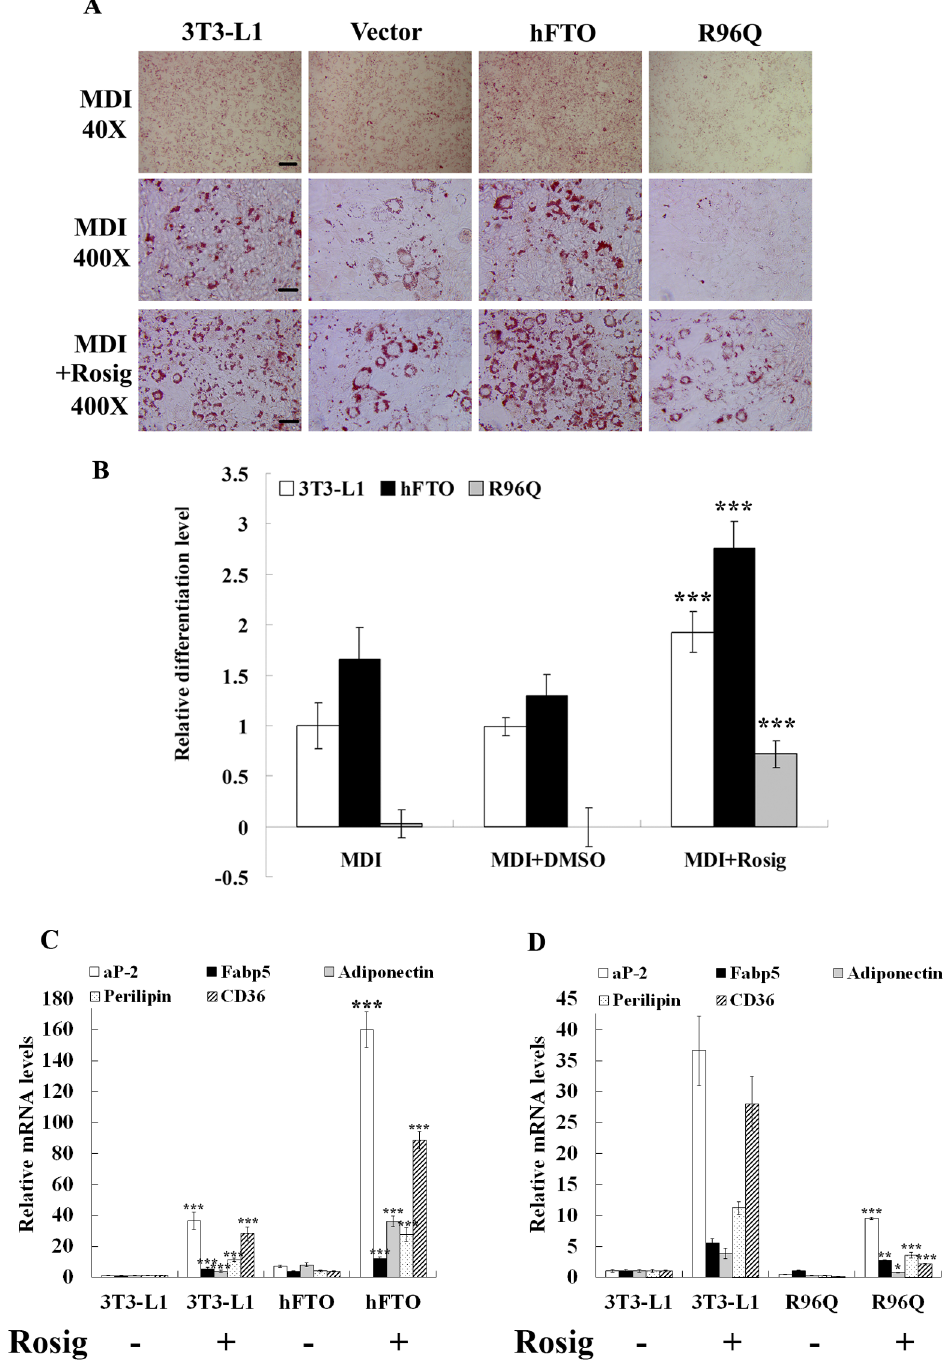
Fig 3. Rosiglitazone rescued adipogenesis inhibition in 3T3-L1 cells expressing R96Q. (A) Oil Red-O staining of 3T3-L1 cell lines treated with MDI (top and middle row), or MDI plus Rosiglitazone (bottom row). Scale bars are 500 μ m in 40x images and 50 μ m in 400x images respectively (left column). (B) Level of differentiation in 3T3-L1 lines expressing wt hFTO-4 or R96Q-4, measured by the extent of Oil Red-O staining. Expression levels of five PPAR γ target genes (aP-2, Fabp5, Adiponectin, Perilipin and CD36) were evaluated in 3T3-L1 over expressing wt hFTO-4 (C) or R96Q-4(D) at day 3 post differentiation induction. All gene expression data are represented as mean ± SD of triplicates. * stands for p < 0.05, ** stands for p < 0.01 and *** stands for p < 0.001 in Student ’ s t-test (Rosig versus DMSO)